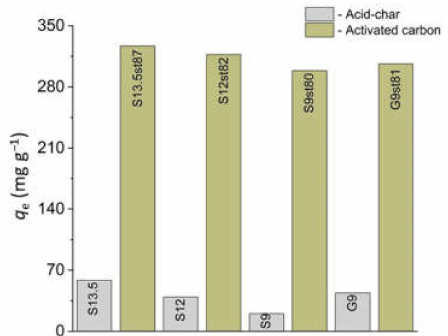
Figure 8. Ibuprofen uptake on acid-chars and activated carbon samples at pH 5.5 (experimental conditions: temperature 30 ◦ C, initial concentration 120 mg L − 1 , volume 9 mL, weight of adsorbent: 12 mg for acid-chars and 6 mg for activated